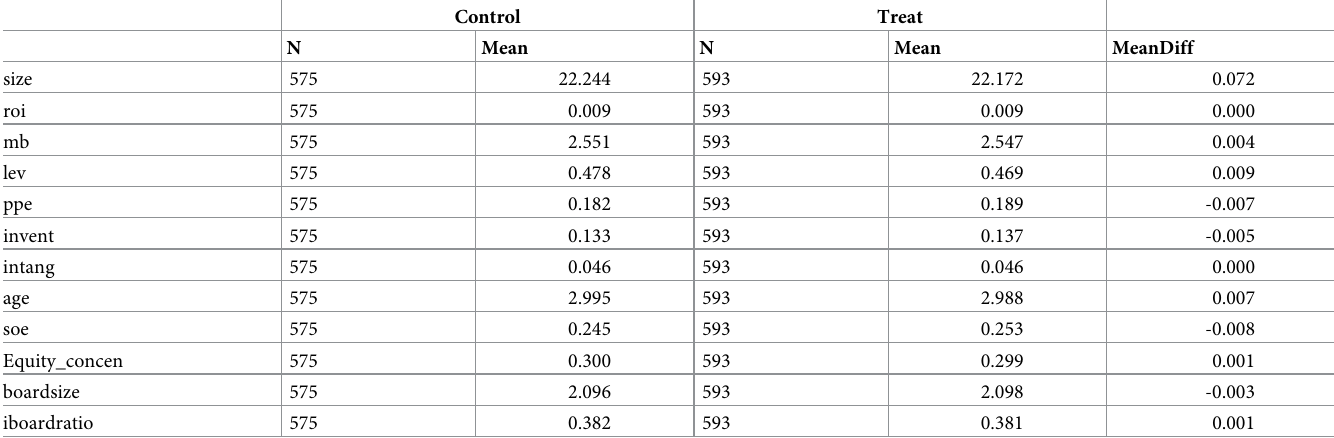
Table 7. Covariate balance of PSM sample.